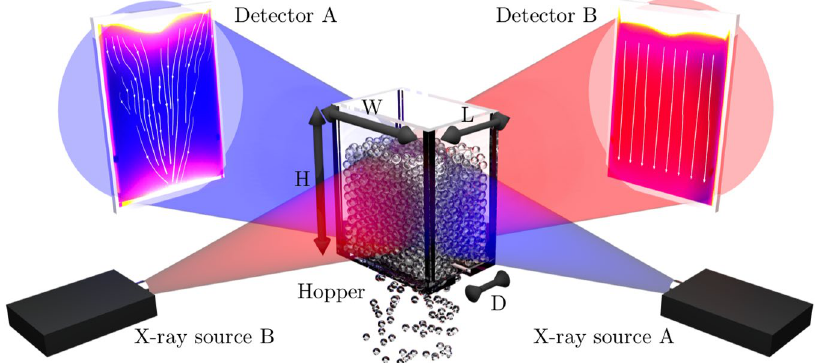
Figure 1. Schematic representation of the experimental setup with the two X-ray arrangements investigated here (A, shown in blue and B, shown in red). Between the source and the detector a flat-bottomed rectangular silo is placed, of size L × W × H , with an outlet at the base of size D × W